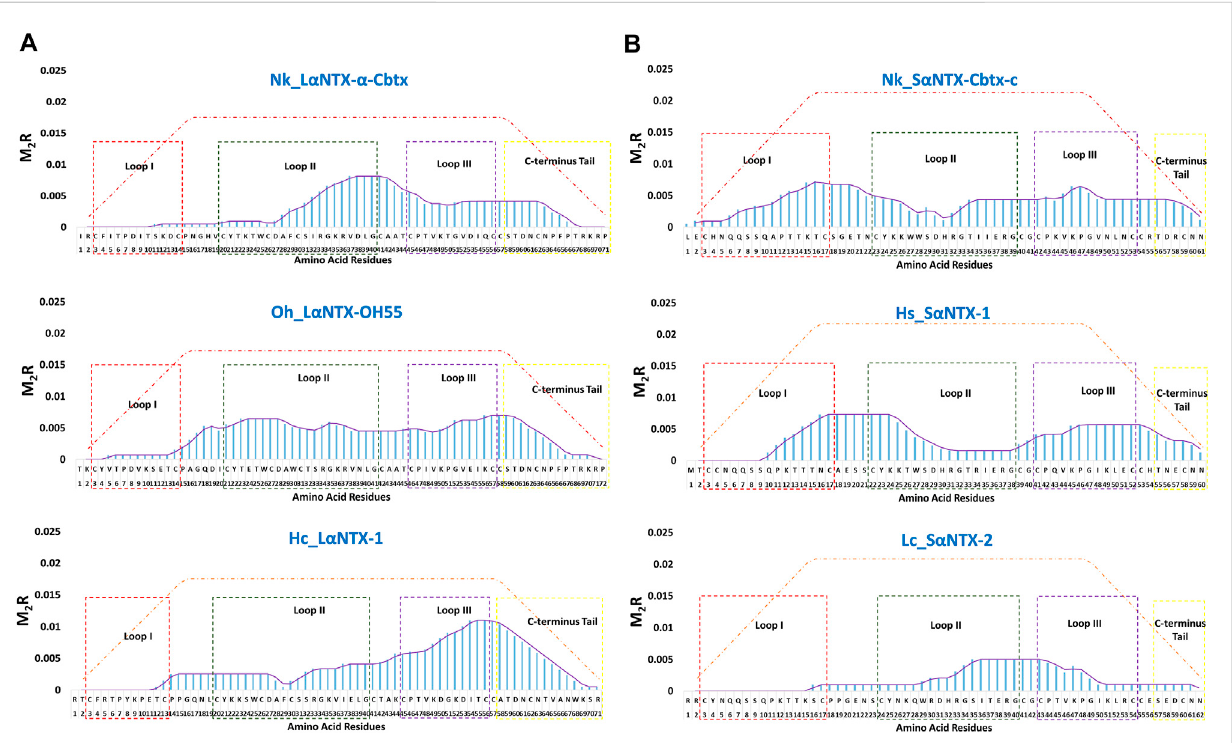
FIGURE 7 Theimmunodominantcoverageacrosstheaminoacidsequencesof α -neurotoxins. (A) Long-chainalpha-neurotoxins(L α NTX),and (B) Short-chain alpha-neurotoxins (S α NTX). Dashed squares in the fi gure represent the different loops and C-terminus tail of α -NTXs. The brown-dash dotted line indicates the maximum score of respective amino acid residues. Abbreviations: Nk_L α NTX- α -Cbtx, α -cobratoxin (UniProt ID: P01391, N. kaouthia ); Oh_ L α NTX-OH55, long neurotoxin OH55 (UniProt ID: Q53B58, O. hannah ); Hc_L α NTX-1, long neurotoxin 1 (UniProt ID: Q8UW29, H. curtus ); Nk_ S α NTX-Cbtx-c,cobrotoxin-c(UniProt:P59276, N.kaouthia );Hs_S α NTX-1,shortneurotoxin1(UniProtID:P68415, H.schistosus );andLc_S α NTX-2,short neurotoxin 2 (UniProt ID: P10457, L. colubrina ). The details analyses were provided in Supplementary File S1.